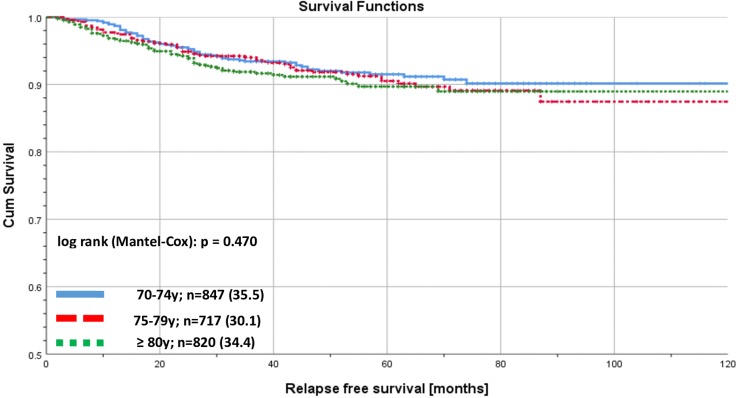
Recurrence free survival for early breast cancer patients aged ≥ 70 years.Kaplan-Meier curves of recurrence free survival for early breast cancer patients aged 70 years and older, stratified by age.